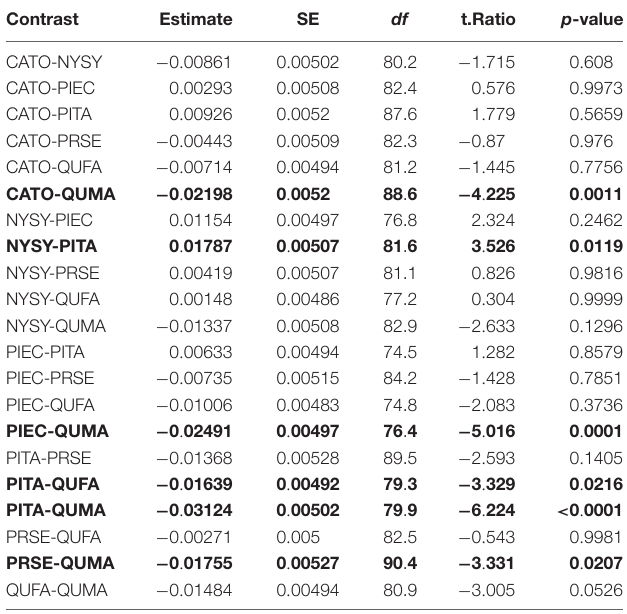
TABLE 6 | Pairwise comparisons of the model B r ∼ OBT + Species + (1 |